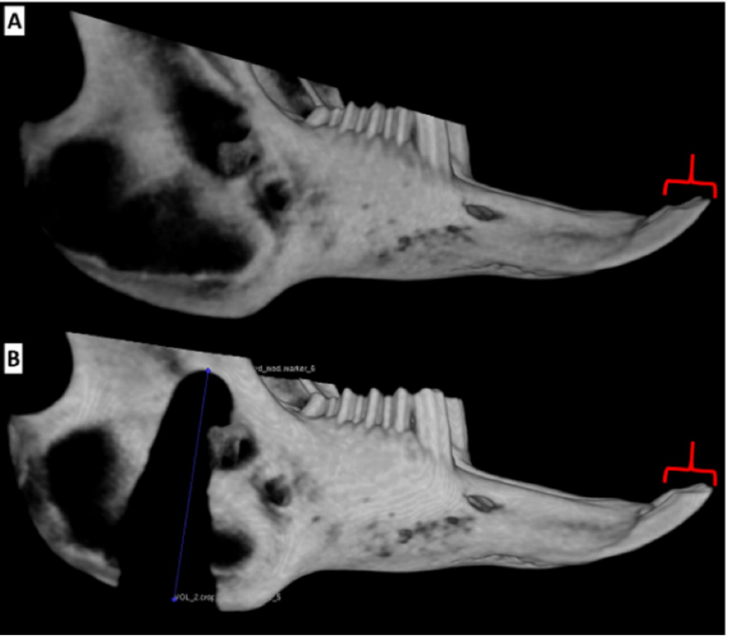
Figure 9. Reconstructed CBCT volumes of the rabbit right hemimandible ID. ( A ) Baseline image. ( B ) Image of the defected mandible 3 weeks following surgery. The line in the lower image measures the defect at 23 mm. The defect resulted in no changes of the ipsilateral incisor with retained morphologic symmetry (indicated by red brackets) between sides at all imaging time points. CBCT: cone beam computed tomography, ID: intermediate